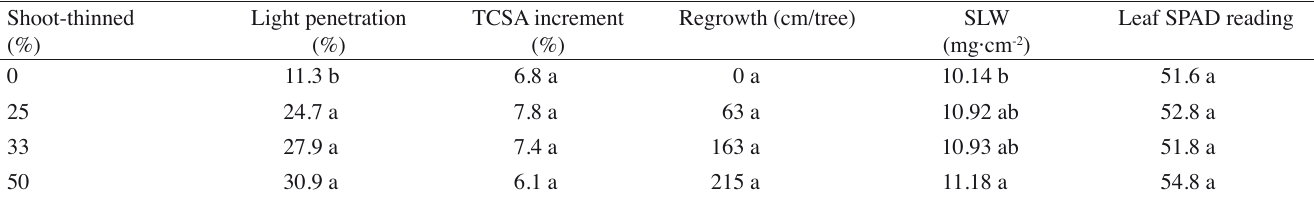
Table 1 - Effect of summer pruning severity on 29 July on light penetration and tree growth of ‘Nishimurawase’ persimmon (Choi et al ., 2003 b)